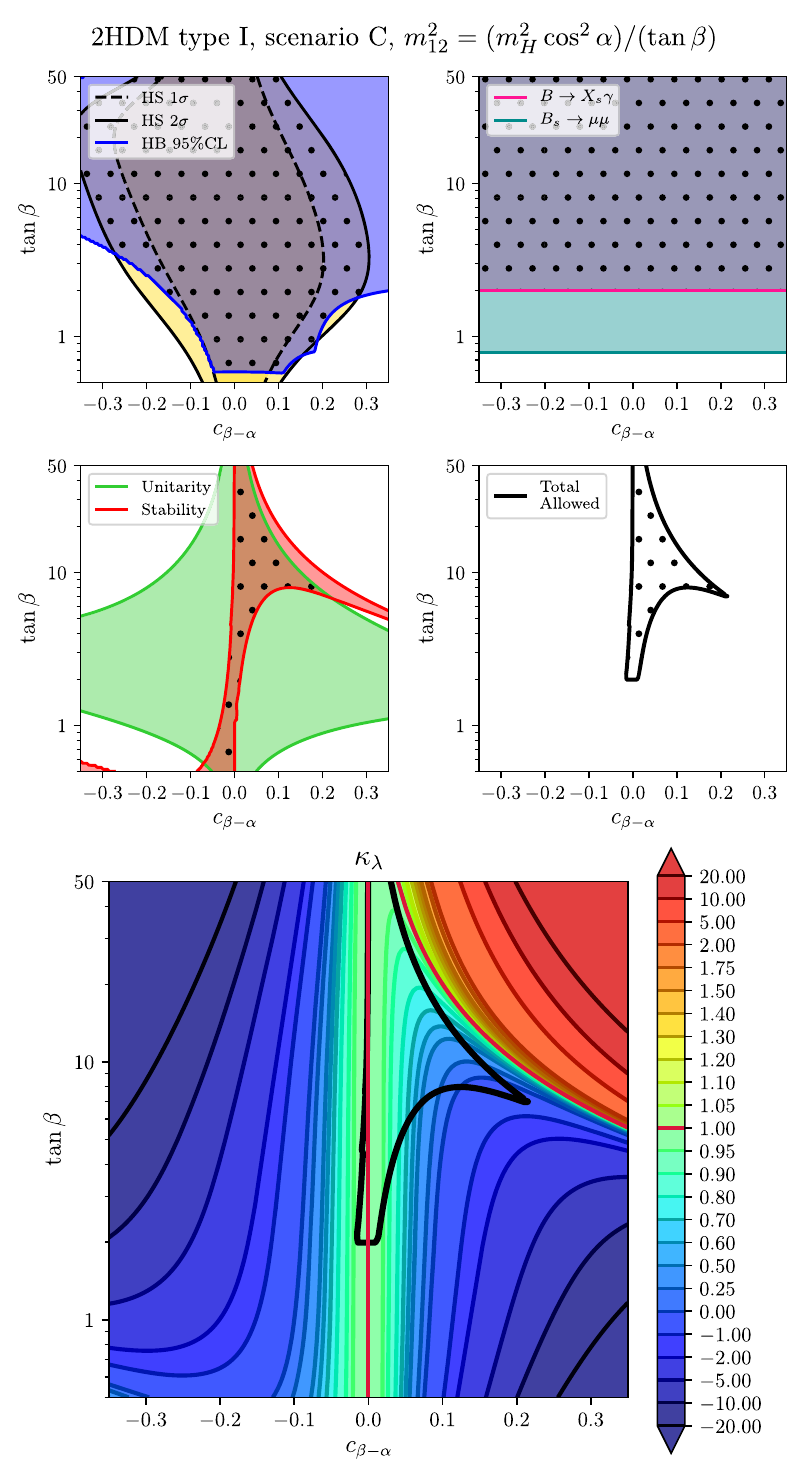
Fig. 8 Predictionsfor κ λ = λ hhh /λ SM inthe2HDMtypeI,scenarioC, for m H = m A = m H ± = 1000 GeV and m 2 in the ( c β − α , tan β) plane. Upper left plot: Allowed areas by direct searches at colliders (blue), constraints from the SM-like Higgs boson properties (yellow) and both (dotted). Upper right plot: Allowed areas by flavor physics from B → X s γ (pink), B s → μ + μ − (teal) and